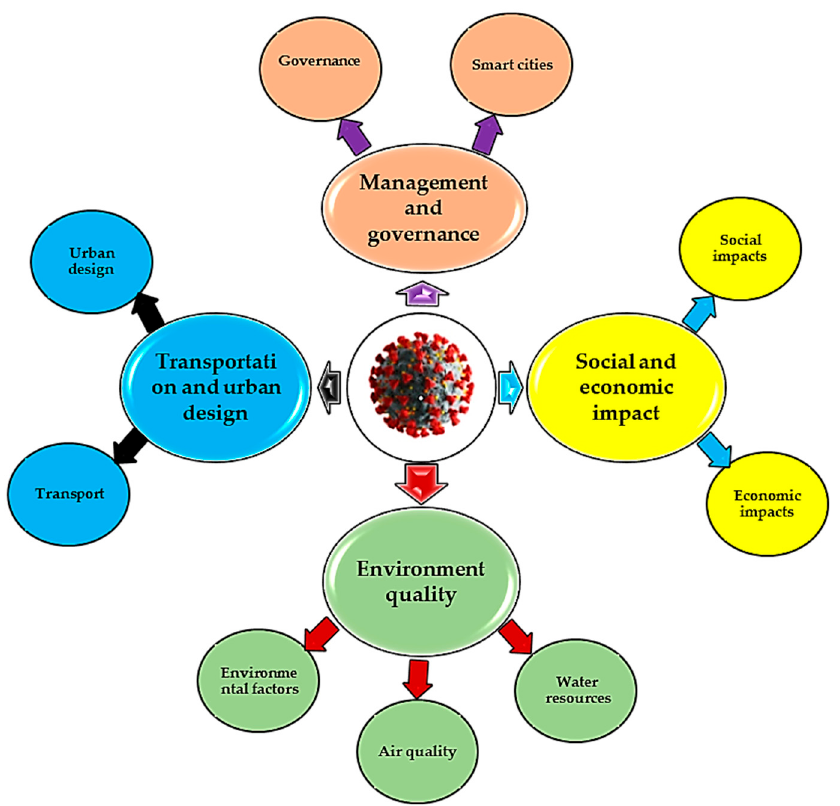
Figure 1. Impacts of COVID-19 on municipalities.